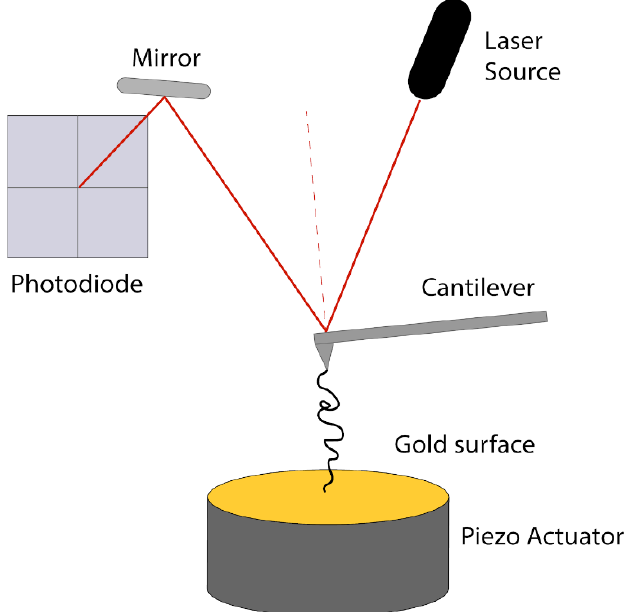
Figure 9. Atomic force microscope (AFM)-based Single Molecule Force Spectroscopy (SMFS) set-up. A laser beam is reflected at the back of the cantilever and then after redirected from a mirror, it is reaching the photodiode. Movement of the cantilever due to pulling of the biomolecule is causing changes to the signal detected by the photodiode. The sample is placed on a gold surface, placed on a piezo actuator, which controls the x-y-z movement of the sample.